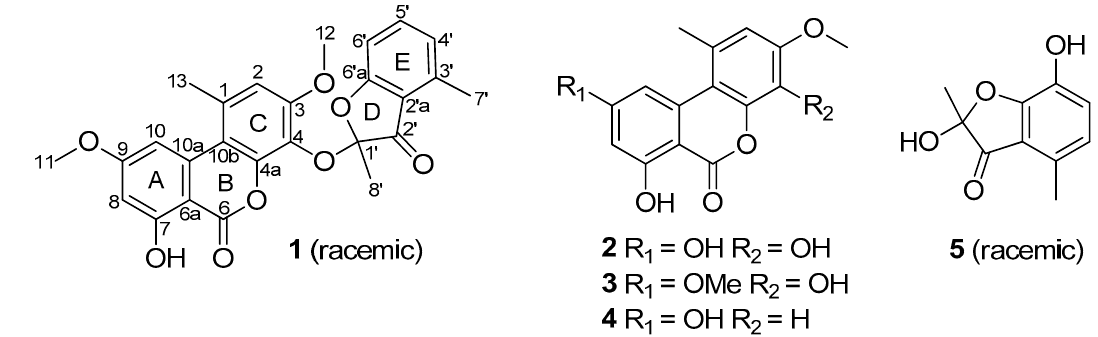
Figure 1. Structures of compounds 1 – 5